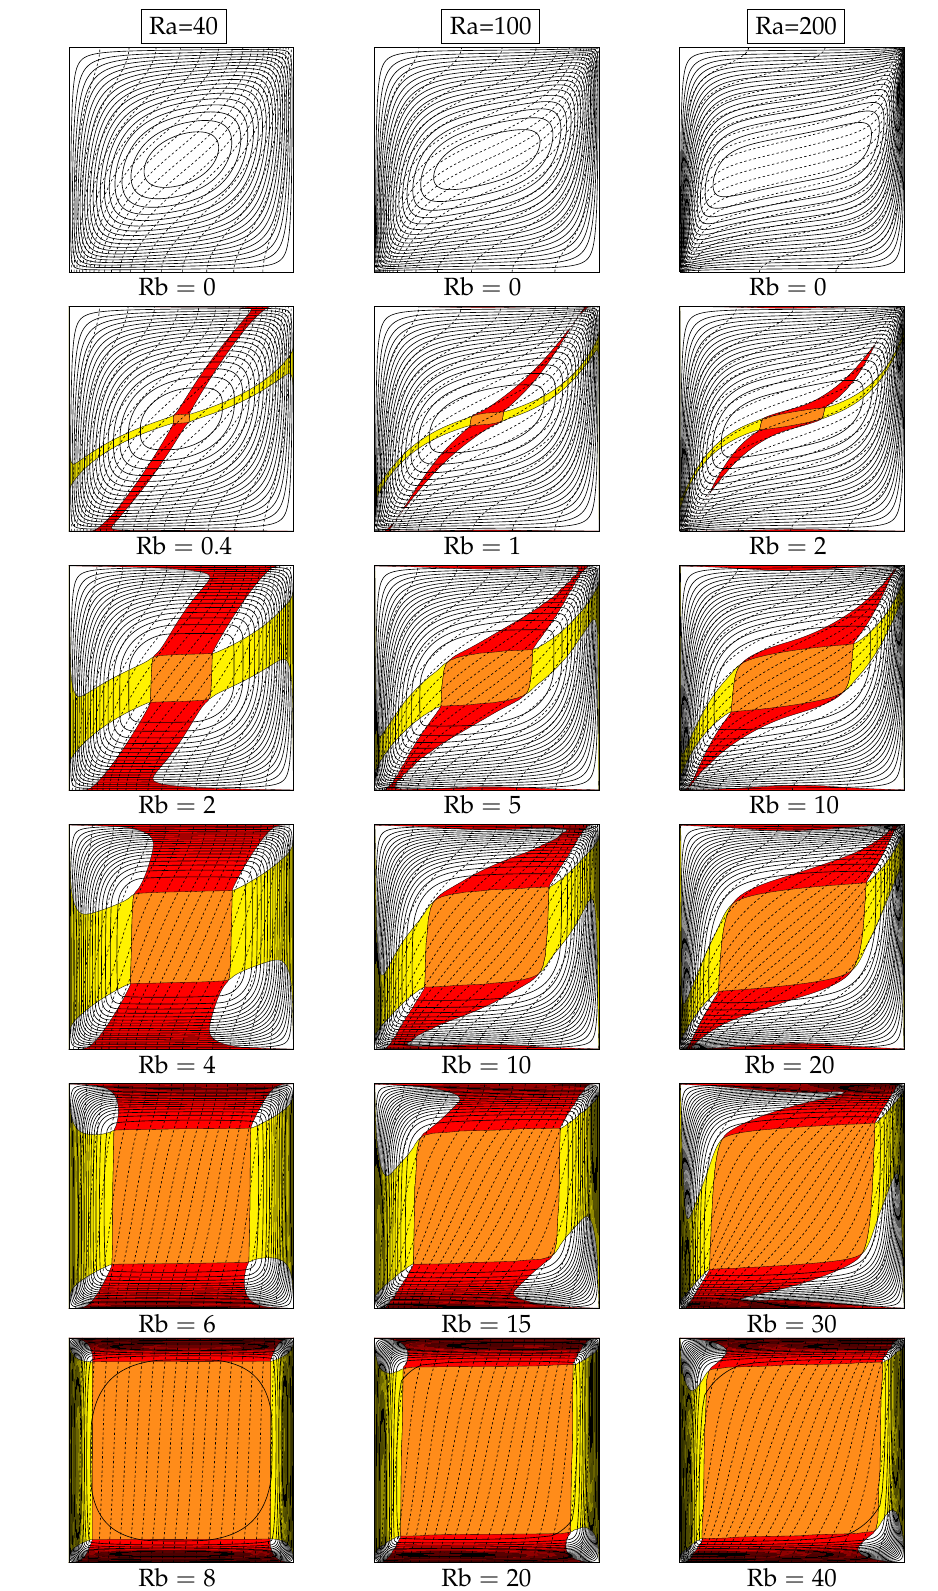
Figure 1. Streamlines (continuous) and isotherms (dashed) using a square-network-based anisotropic model and with the given parameters. Red indicates vertical stagnation, yellow for horizontal stagnation and orange for total stagnation. Ra is the Darcy–Rayleigh number and Rb is the the Rees–Bingham